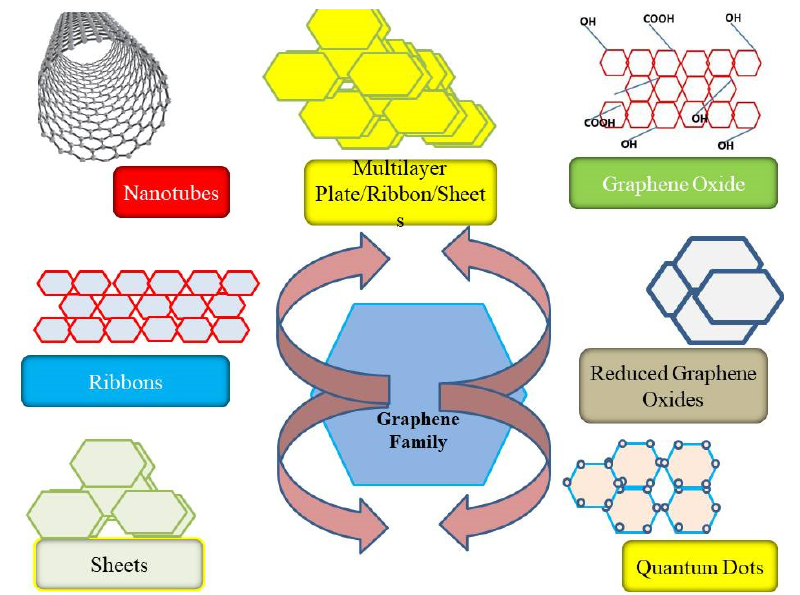
Figure 2. Different forms of GN-based nanomaterial.